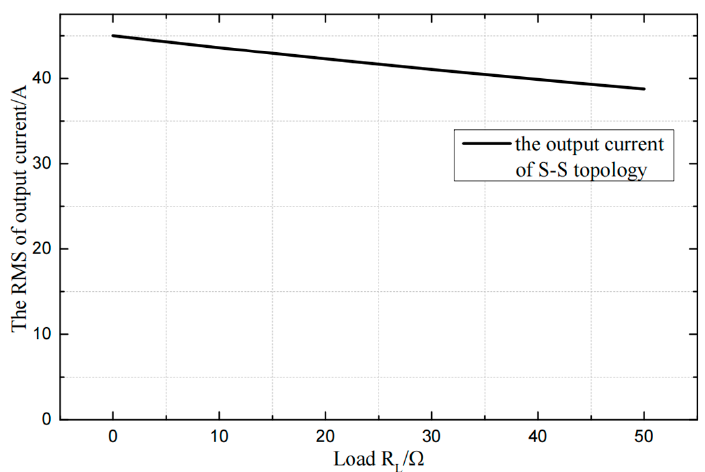
Figure 11. Dual-LCL system load-output current characteristic curve.